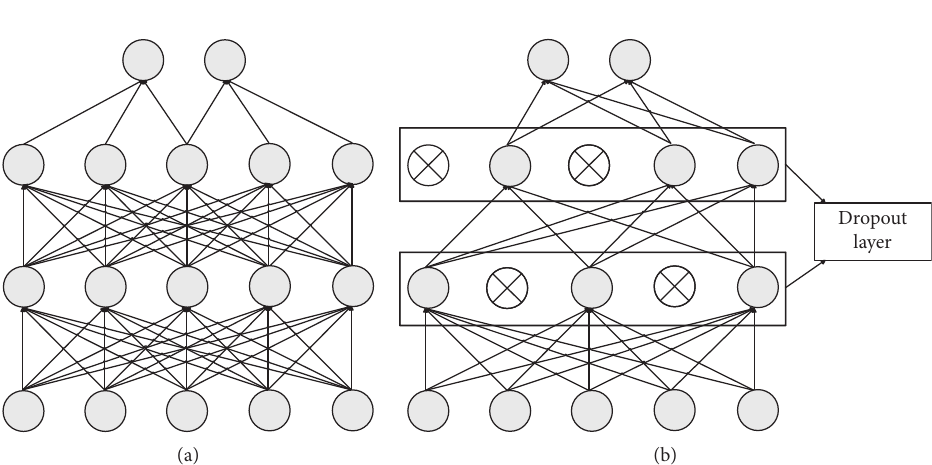
Figure 2: Comparison of neural network (a) and (b) neural network with dropout layer.